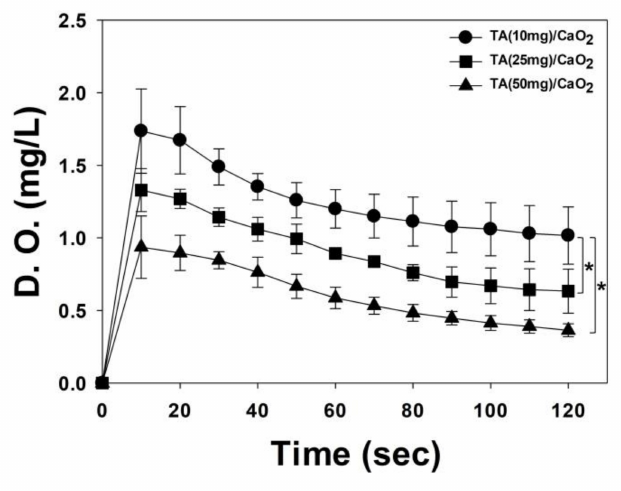
Figure 4. Oxygen concentration in suspensions of TA (10 mg) / CaO 2 , TA (25 mg) / CaO 2 , and TA (50 mg) / CaO 2 nanoparticles, as measured using a portable dissolved oxygen meter. The data represent mean ± SD (n = 3). * p <